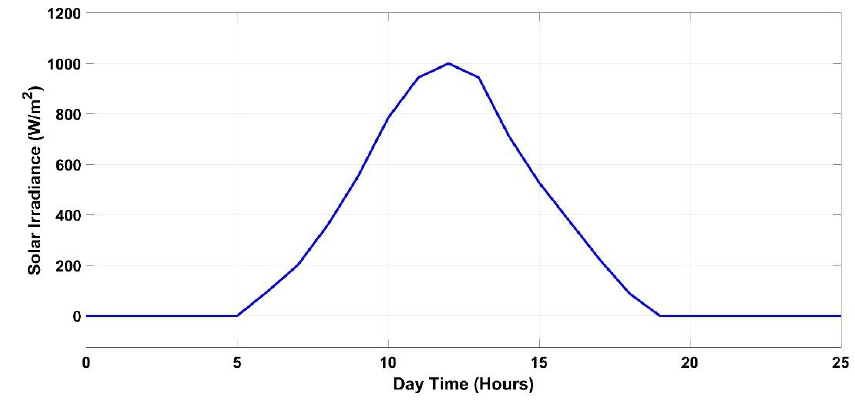
Figure 17. Fluctuation of solar radiation.